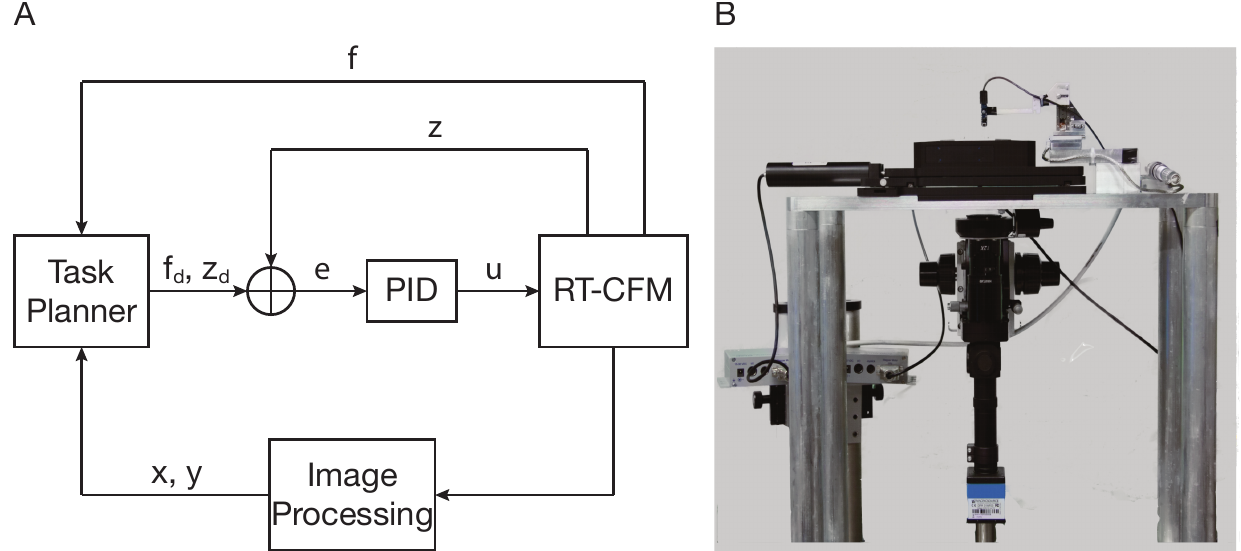
Figure 2. The real-time cellular force microscope (RT-CFM). ( A ) Schematic representation of the RT-CFM. f and z are the measured values, and f and position, respectively. e is the error between the desired and the measured values of force and position, and u is the control signal that is fed into the RT-CFM positioner. x and y are the coordinates of the measurement location to which the system has to be positioned.